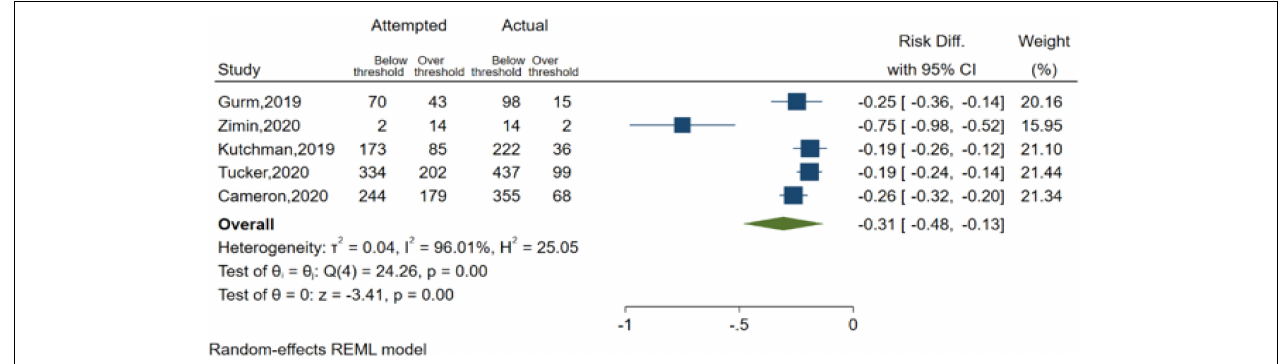
FIGURE 3 | Contrast media volume threshold management in the DyeVert